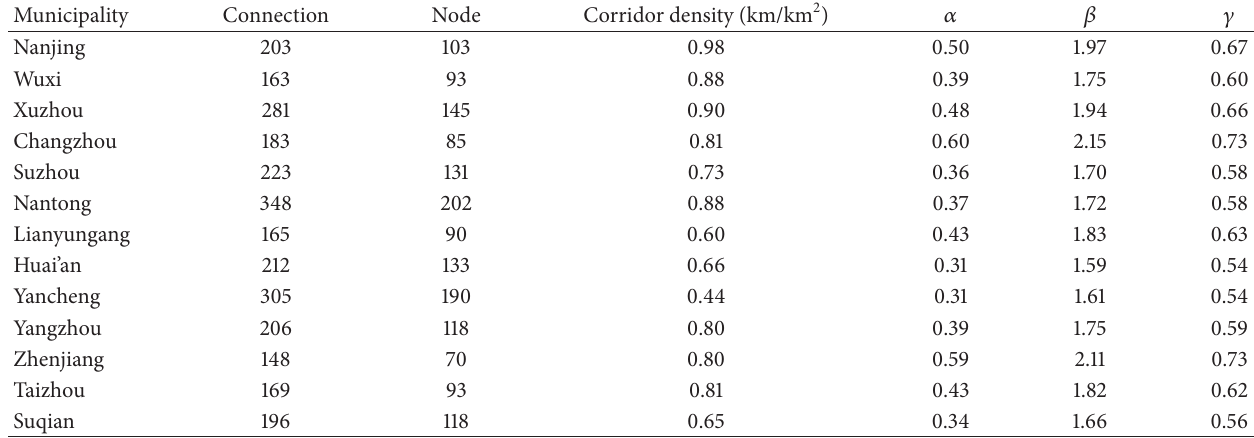
Table 2: Traffic network indices.